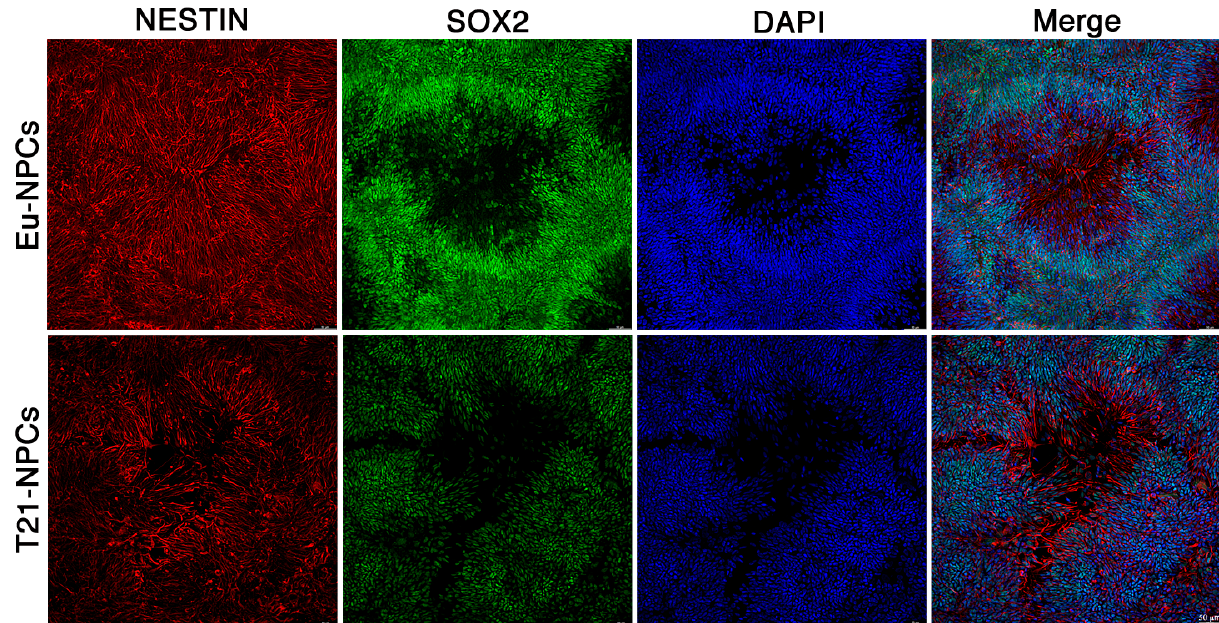
Figure 7. Expression of NESTIN and SOX2 in Eu-NPCs and T21-NPCs at day 21 of culture. Immunofluorescence detection of NESTIN (red), SOX2 (green) and DAPI (blue) at day 21 of treatment with differentiation medium. T21-NPC images are representative of the two trisomic clones. The nuclei, stained in green or blue, are clustered in some areas. NESTIN filamentous pattern is clearly detected in areas without nuclei. Pictures were taken at the THUNDER Imaging Systems. Bar = 50 μ m.